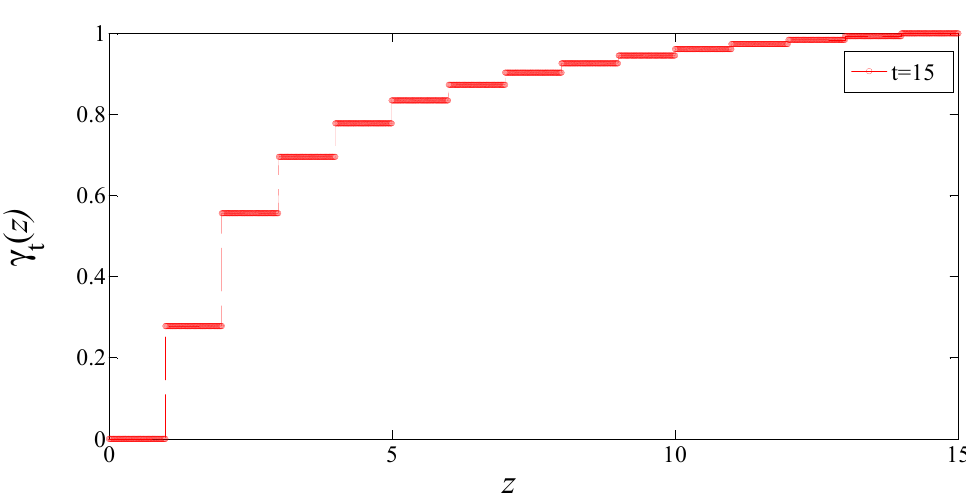
N . Figure 2. Uncertain distribution Υ t